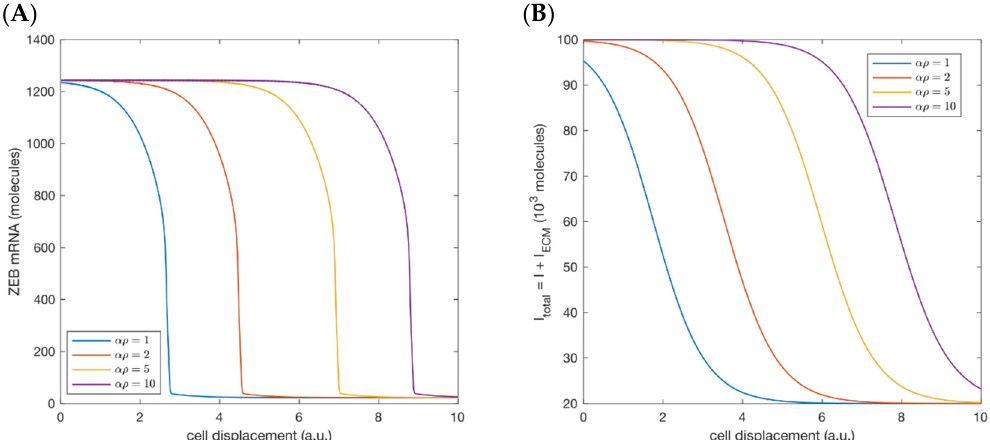
Figure 5. For different αρ / λ , there is a sharp variation in ( A ) ZEB mRNA level and ( B ) total EMT-inducing signal, as the cell travels away from the primary tumor with a constant velocity in a heterogeneous LOXL2-modifed ECM.